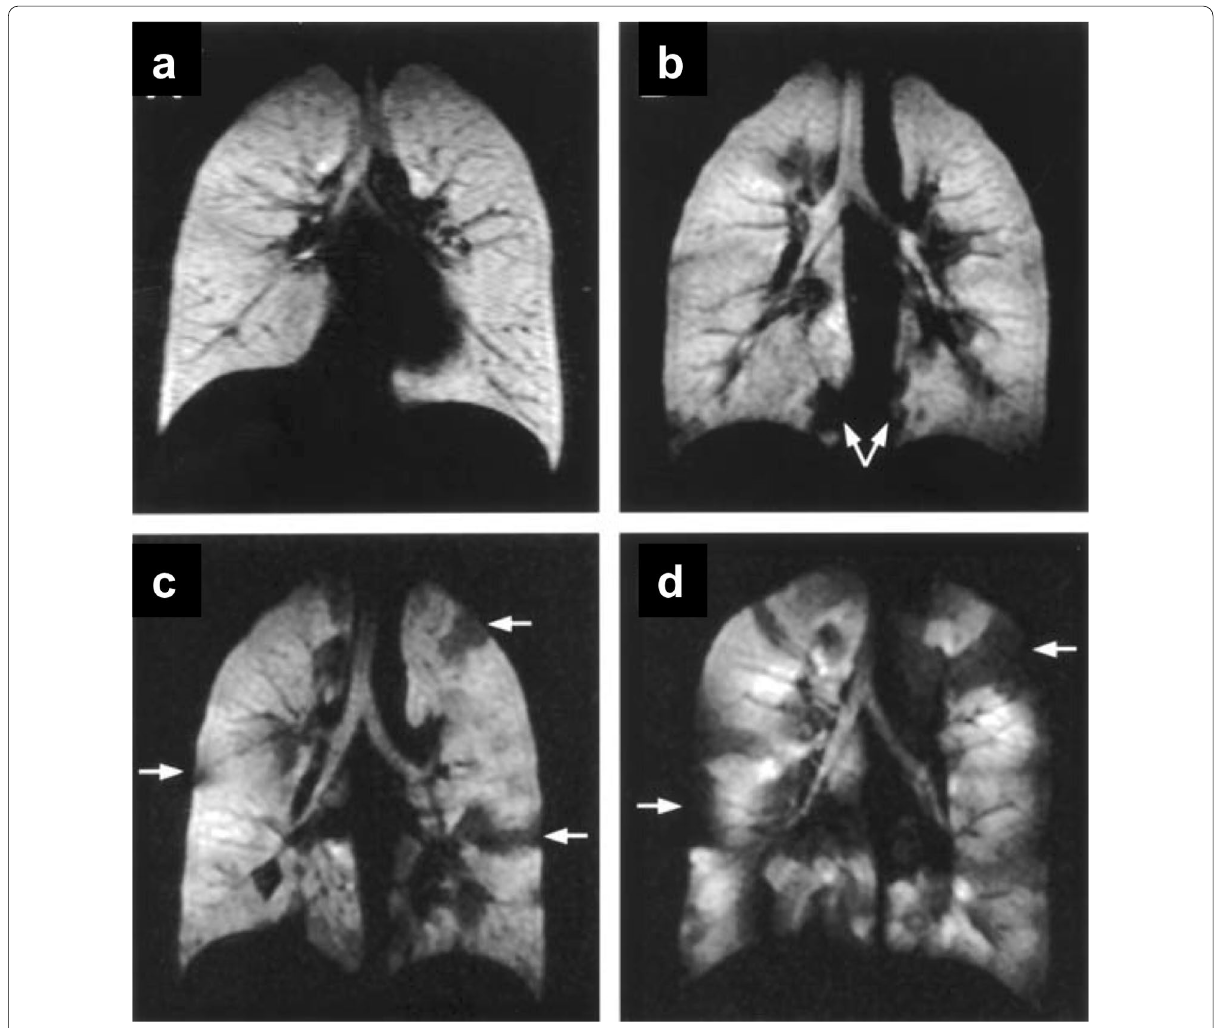
Fig. 7 Coronal MR images obtained immediately after inhalation of hyperpolarized Helium-3 gas in a healthy normal volunteer ( a ) and in patients with mild (FEV1 of 132% of predicted value. b Moderate (FEV1 of 83% of predicted value. c Severe (FEV1 of 34% of predicted value. d Asthma. The distribution of the gas is homogenous in the normal volunteer, and ventilation defects are seen with increasing numbers in the asthmatic patients with increasing severity (arrows pointing at several defects). Reproduced with permission from Elsevier Ltd (License Number: 5324281420540). J Allergy Clin Immunol. 2003